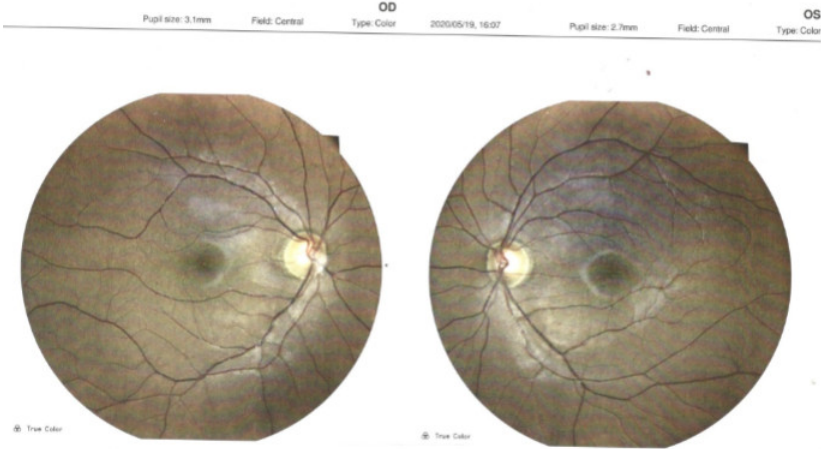
Figure 5. Retino Figure 5. Retinophotography.